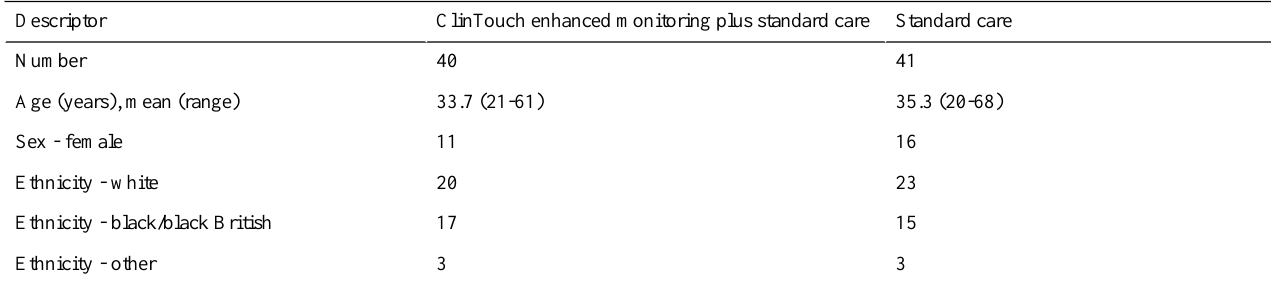
Table 1. Demographic data by treatment group.